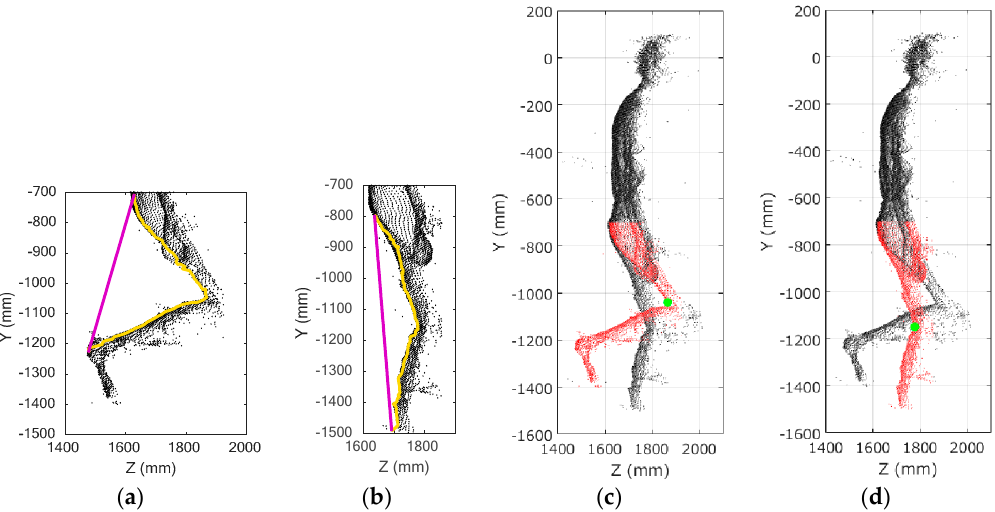
Figure 8. Knee joint position extraction: ( a ) plots of the left leg with representative positions (yellow line) and line connecting the top and bottom of the representative positions (purple line); ( b ) plots of the right leg with representative positions (yellow line) and line connecting the top and bottom of the representative positions (purple line); ( c ) plots of the left leg area (red dots) and estimated knee joint position of the left leg (green dot); ( d ) plots of the right leg area (red dots) and estimated knee joint position of the right leg (green dot).